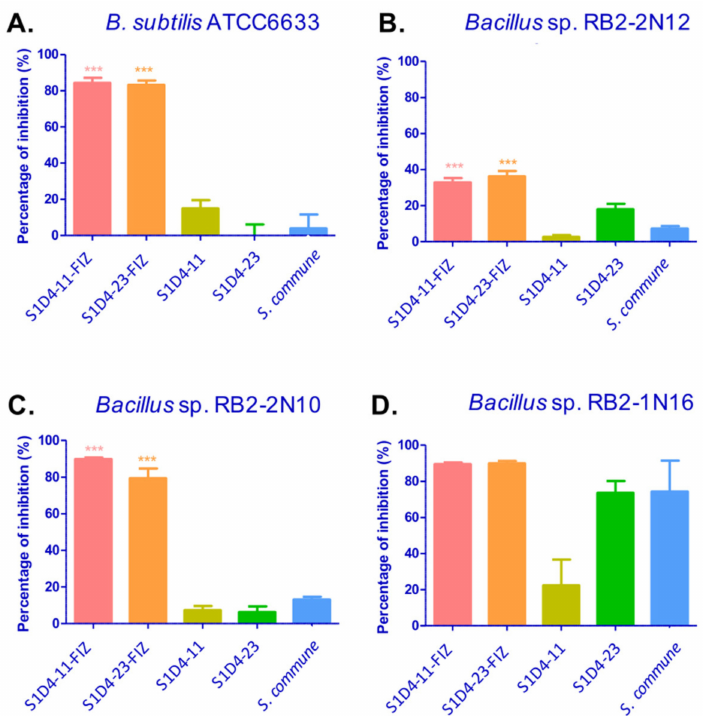
Figure 2. Antimicrobial activities of S1D4-11-FIZ and S1D4-23-FIZ against different Bacilli . Inhibition was quantified as a percentage of growth inhibition in comparison with a control without extract. The growth was measured by spectrometry at OD 600 nm after 24 h of growth. The different Bacilli strains are ( A ) Bacillus subtilis ATCC6633, ( B ) Bacillus sp. RB2-2 N12, ( C ) Bacillus sp. RB2-2 N10, and ( D ) Bacillus sp. RB2-1 N16. Statistical difference was assessed with a t -test. *** = p value < 0.005 for both comparisons between fungus and Streptomyces -fungus interaction zone (SFIZ) and Streptomyces and